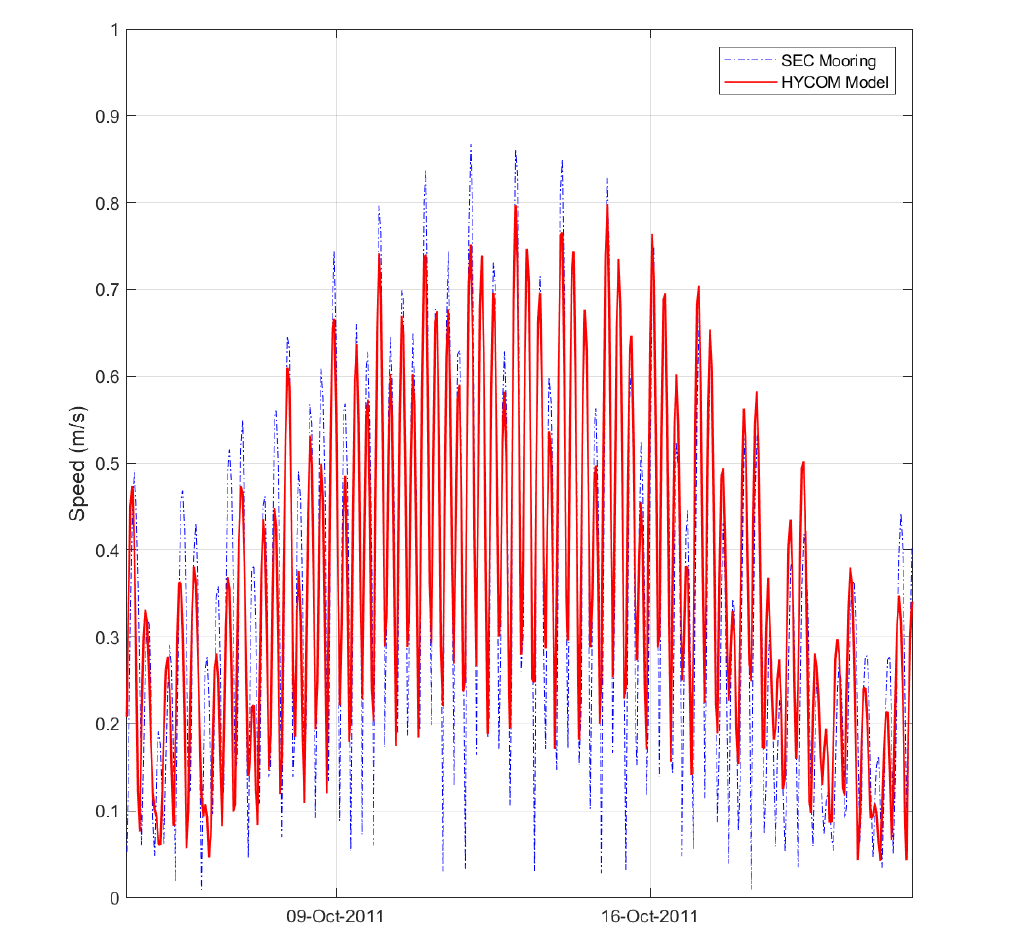
Figure 2. Tidal harmonic reconstruction of the modelled (solid red) and measured (dashed blue) tidal (cid:2) (cid:3) speed ms − 1 time series at the SEC mooring, for the same two-week